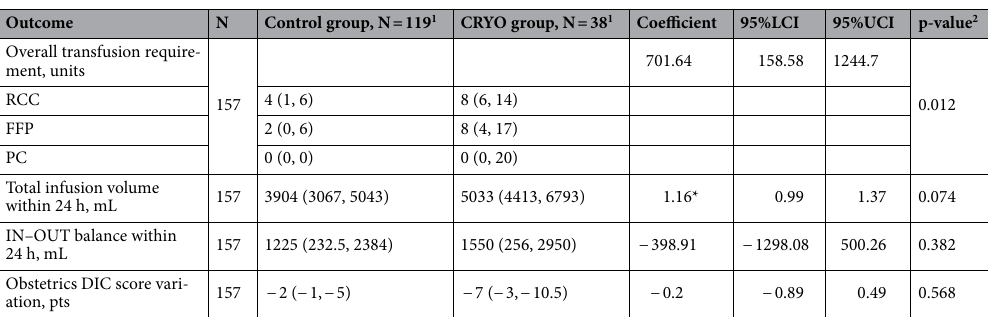
Table 2. Multivariable linear regression analysis. CRYO, cryoprecipitate; RCC, red cell concentrate; FFP, fresh frozen plasma; PC, platelet concentrate; ICU, intensive care unit; DIC, disseminated intravascular coagulation. 1 Statistical data are presented as the median (interquartile range). 2 Statistical tests performed: multivariable linear regression. *Coefficients obtained from multivariable linear regression analysis for log-transformed outcome values are back-transformed to the original scale. This coefficient indicates the fold-increase of the outcome in the Cryoprecipitate group relative to the Control